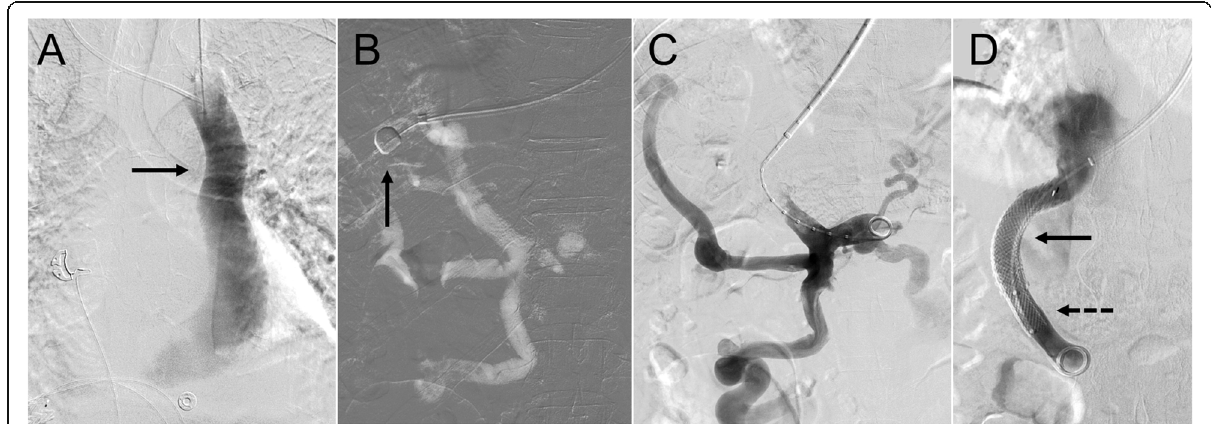
Fig. 1 A middle-aged man with end-stage liver disease, portal hypertension, colovesical fistula, and isolated persistent left superior vena cava. a Left internal jugular venography demonstrating the isolated persistent left superior vena cava (solid arrow). b Wedged portal venography using an occlusion balloon (solid arrow). c The right portal vein was accessed using a Rösch-Uchida needle, and portal venography was performed. A 12-mm × 6-cm (covered) / 2-cm (uncovered) Viatorr stent-graft was deployed. Post-deployment portal venography; however, showed limited